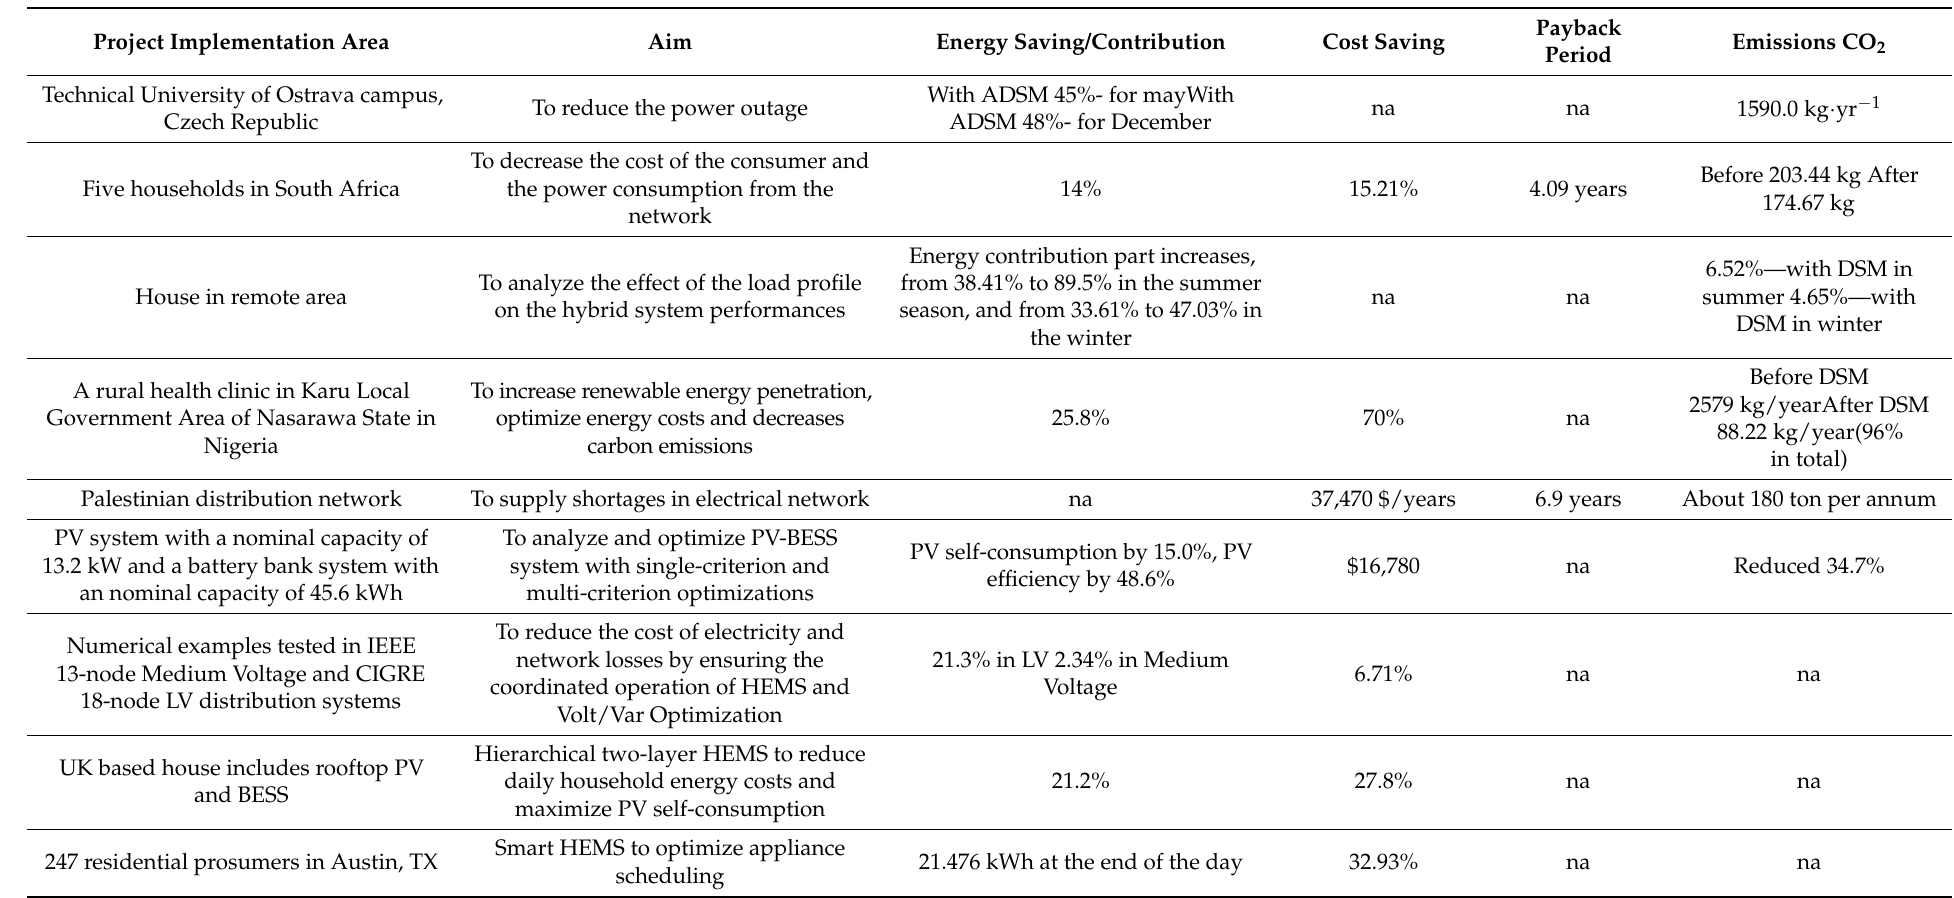
Table 3. Summary of different DSM